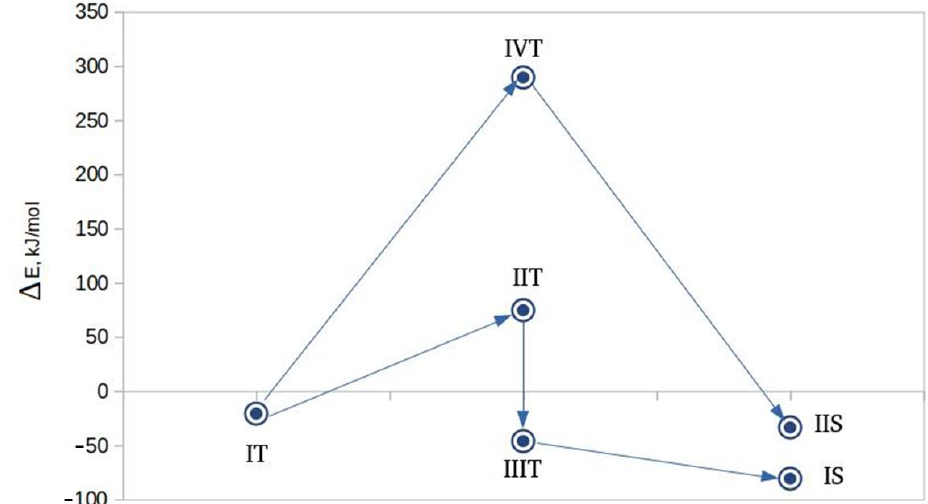
Figure 7. Scheme of the evolution of radical pairs during auto initiation of styrene oxidation.